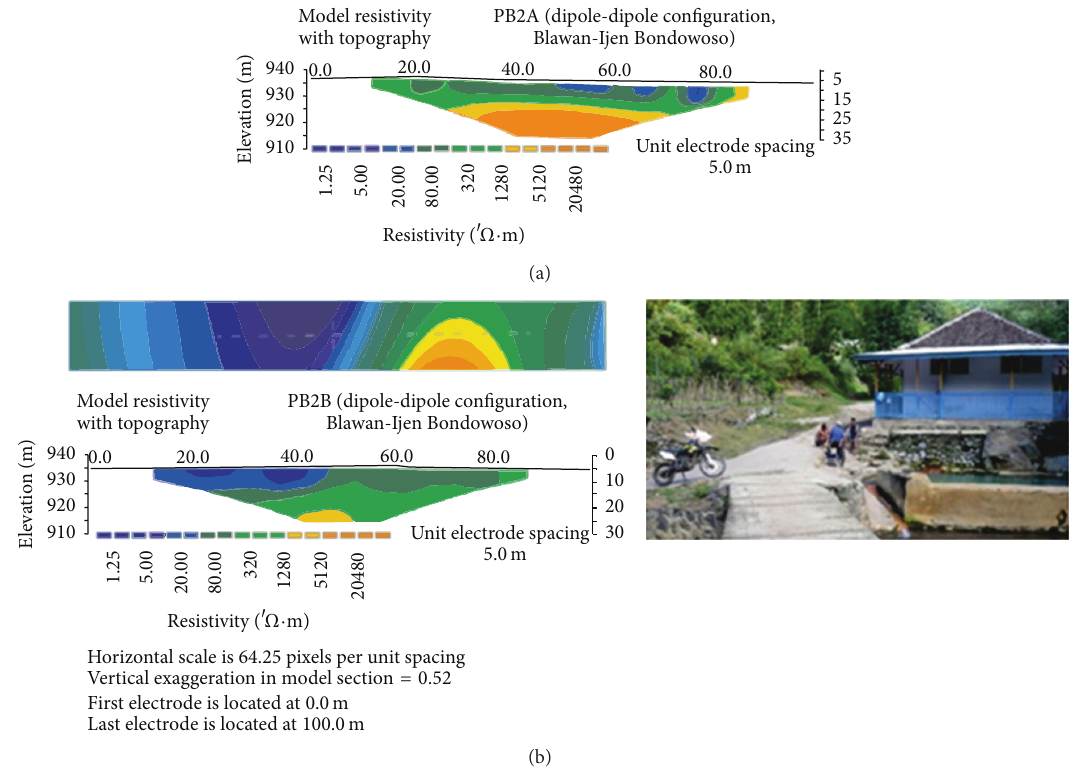
Figure 6: 2D Resistivity Mapping and GPR amplitude slice in locations (a) PB2A and (b)